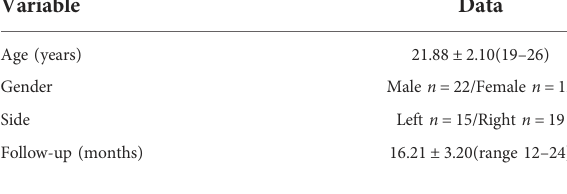
TABLE 2 Results of anatomic ATFL reconstruction with autologous half-bundle peroneus longus tendon for CLAI (mean±standard